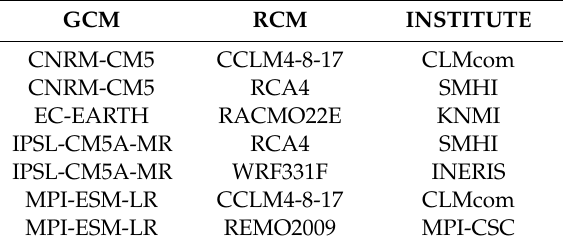
Table 1. Regional climate models ( RCMs) from the Coordinated Regional Climate Downscaling Experiment (CORDEX) project (http://www.cordex.org/) used in this study. GCM = global climate models.